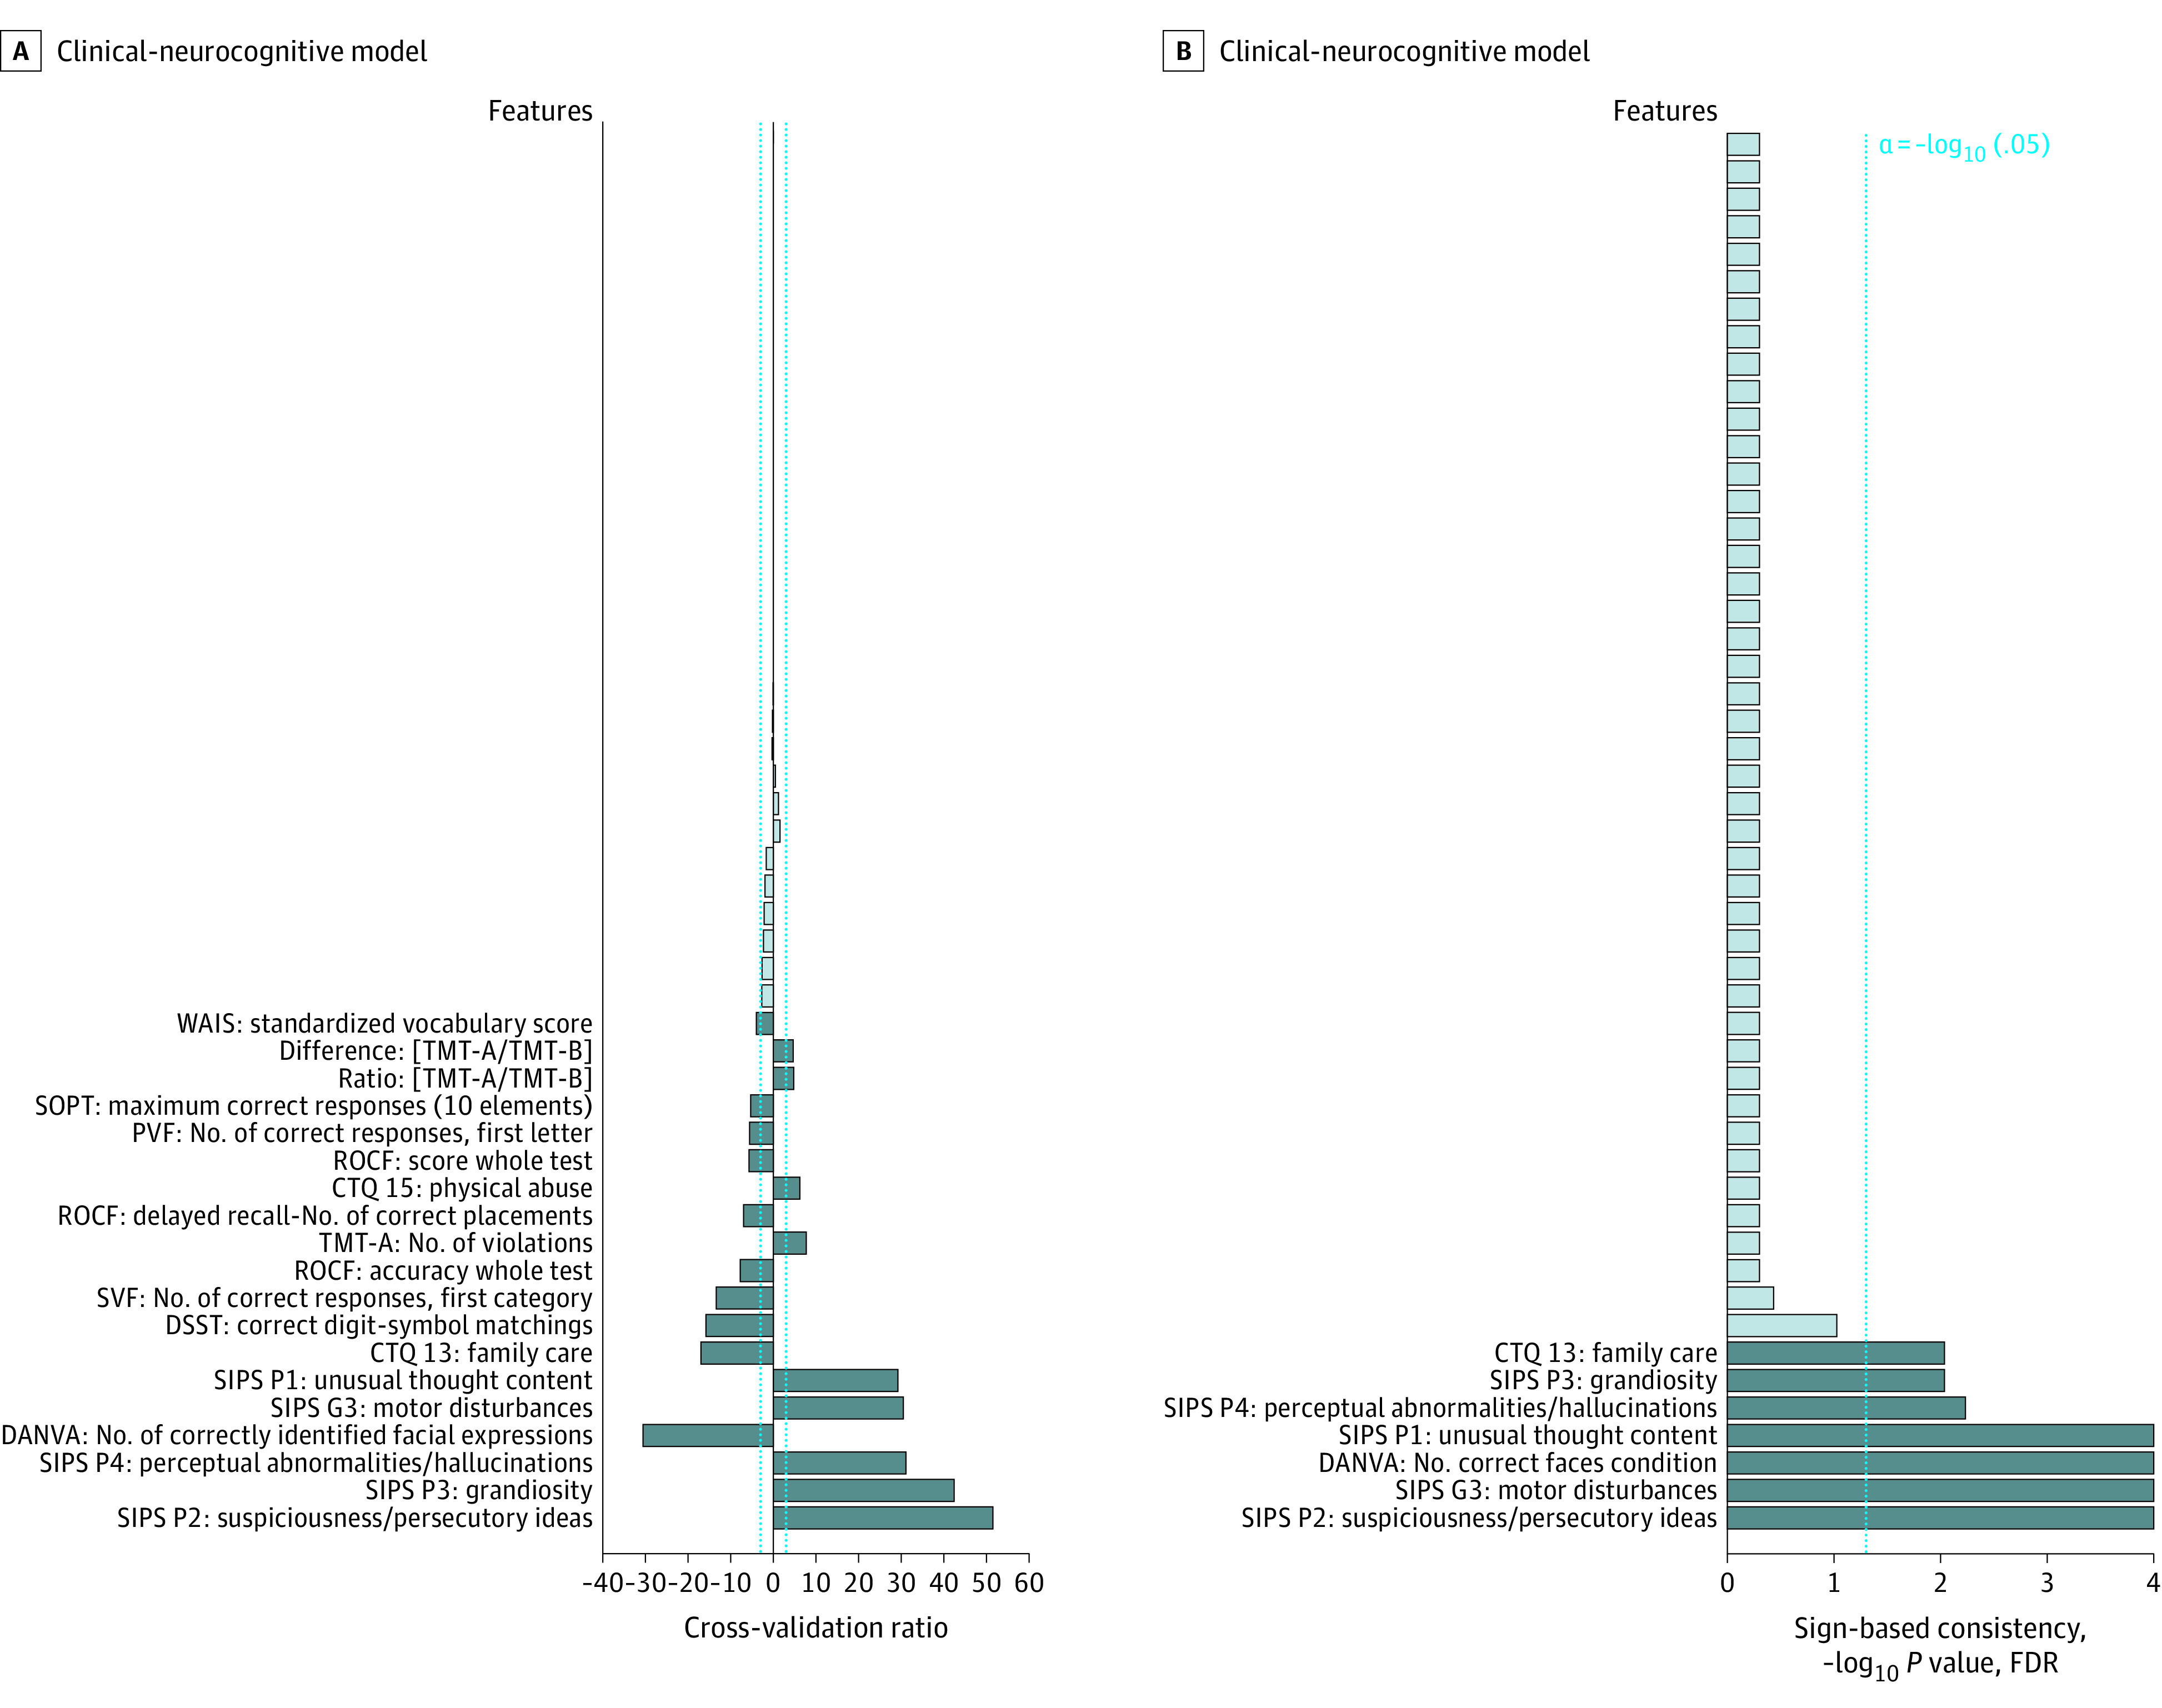
Predictive Signatures Underlying the Clinical-Neurocognitive ModelsThe reliability of predictive pattern elements was evaluated using cross-validation ratio mapping (A). In addition, the significance of predictive features used by the clinical-neurocognitive model was assessed by means of sign-based consistency mapping (B). Both visualization methods are detailed in the eMethods in the Supplement. CTQ indicates Childhood Trauma Questionnaire; DANVA, Diagnostic Analysis of Non-Verbal Accuracy; DSST, Digit-Symbol Substitution Test; FDR, false discovery rate; PVF, Phonetic Verbal Fluency; ROCF, Rey-Osterreith Figure; SIPS, Structured Interview for Psychosis-Risk Syndromes; SOPT, Self-Ordered Pointing Task; SVF, Semantic Verbal Fluency; TMT, Trail Making Test; and WAIS, Wechsler Adult Intelligence Scale.